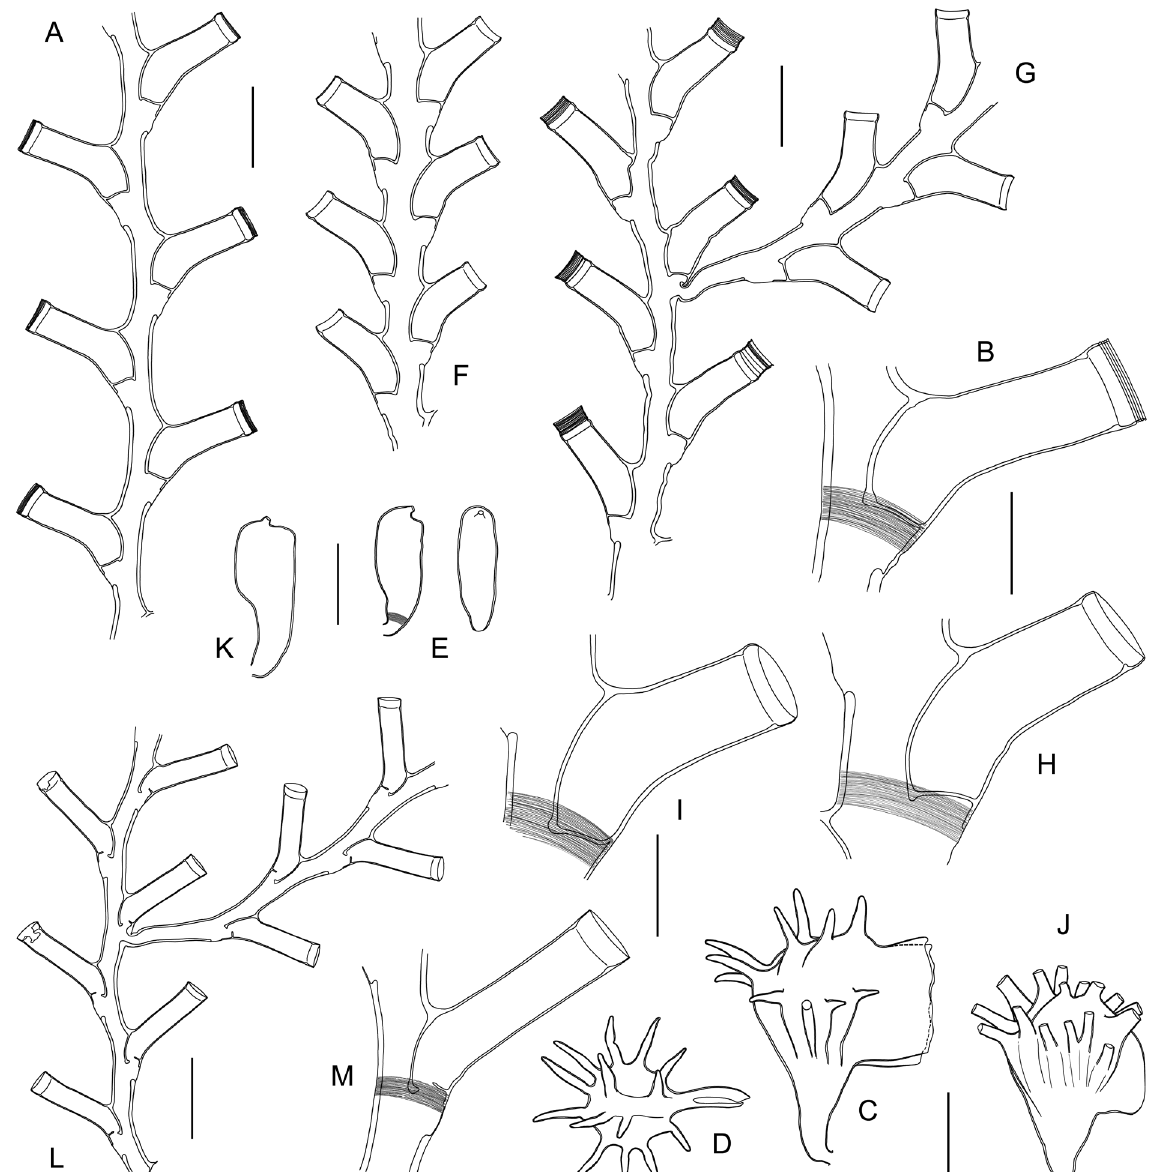
Fig. 3. A–E . ? Solenoscyphus striatus Galea, 2015, branch fragment (A), hydrotheca (B), female gonotheca in lateral (C) and apical (D) views, all from sample MNHN-IK-2015-364; male gonotheca (E) in lateral (left) and frontal (right) aspects, from sample MNHN-IK-2015-368. — F–K . ? S. striatus , morphotype with approximated hydrothecae: colony fragments (E–F, from samples MNHN-IK-2015-376 and MNHN-IK-2015-377, respectively), hydrothecae (H–I, from samples MNHN-IK-2015-378 and MNHN-IK-2015-377, respectively), male gonotheca (K, from sample MNHN-IK-2015-377). — L–M . ? Solenoscyphus subtilis Galea, sp. nov., colony fragment (L), hydrotheca (M), both from sample MNHN-IK-2015-382. Scale bars: B, H–I, M = 500 µm; A, C–G, J–L = 1